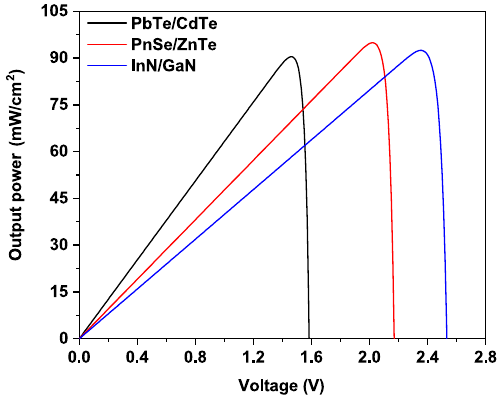
Figure 7. Output power of the QD-IBSC at the full concentration at the optimum pair ( L , H ): ( L = 3.7 nm, H = 2.4 nm), ( L = 3 nm, H = 1.8 nm) and ( L = 3.4 nmn H = 1.3 nm) for PbTe/CdTe, PbSe/ZnTe and InN/GaN QD materials.